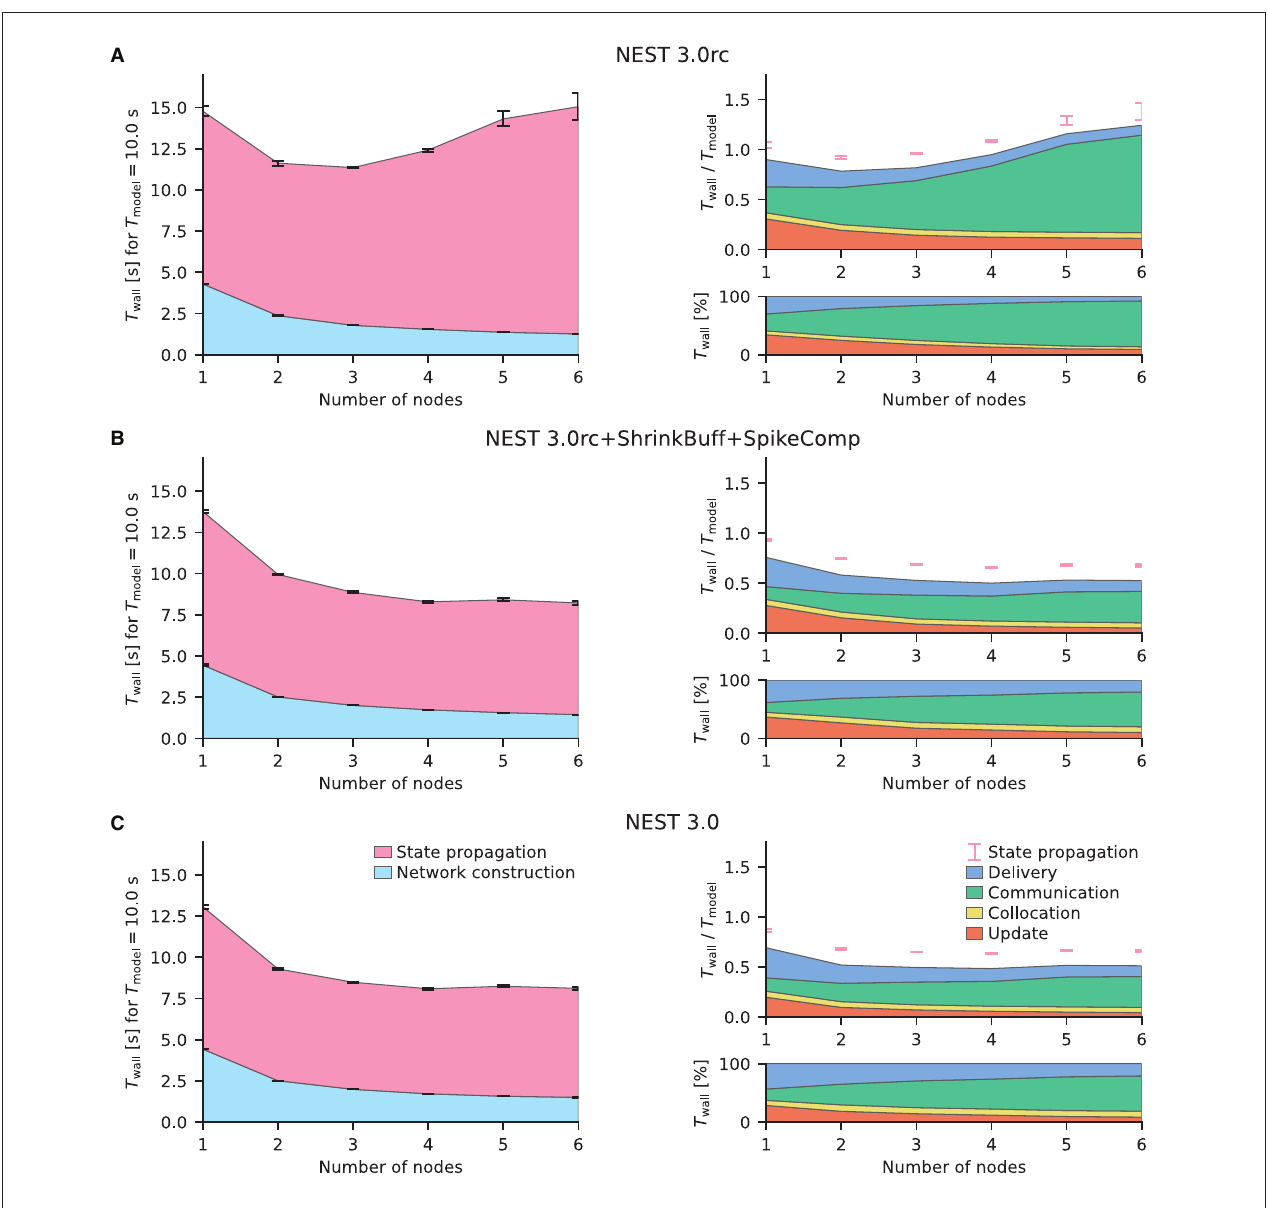
FIGURE 6 | Strong-scaling performance of the microcircuit model on JURECA-DC. Same display as in Figure 4 . The model time is T model = 10s. Simulations are repeated for 10 different random seeds. (A) NEST 3.0 release candidate. (B) NEST 3.0 release candidate with spike compression and shrinking MPI buffers. (C) NEST 3.0